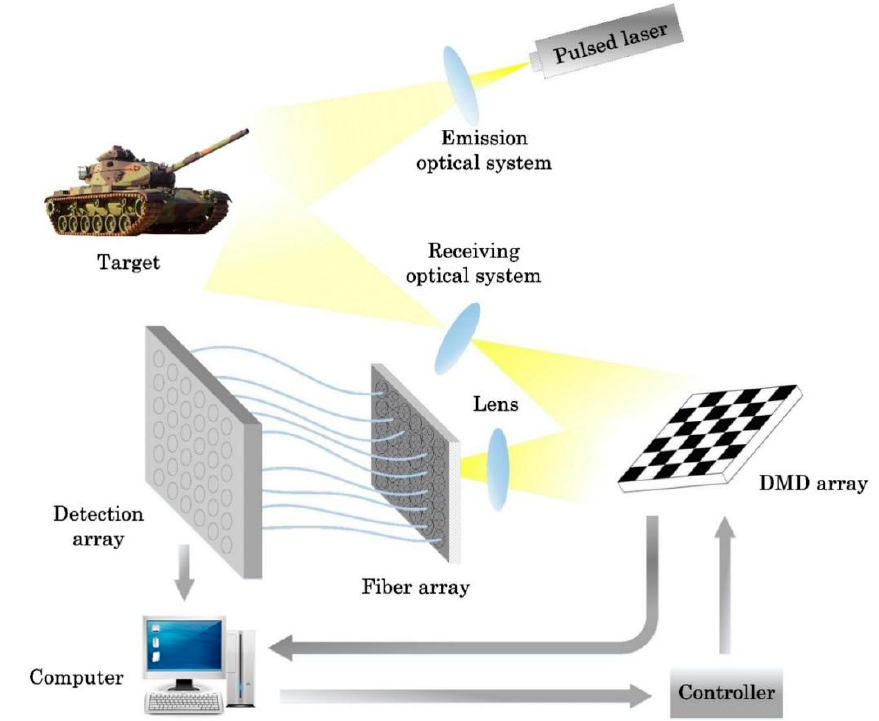
Figure 4. Schematic diagram of the proposed imaging system.